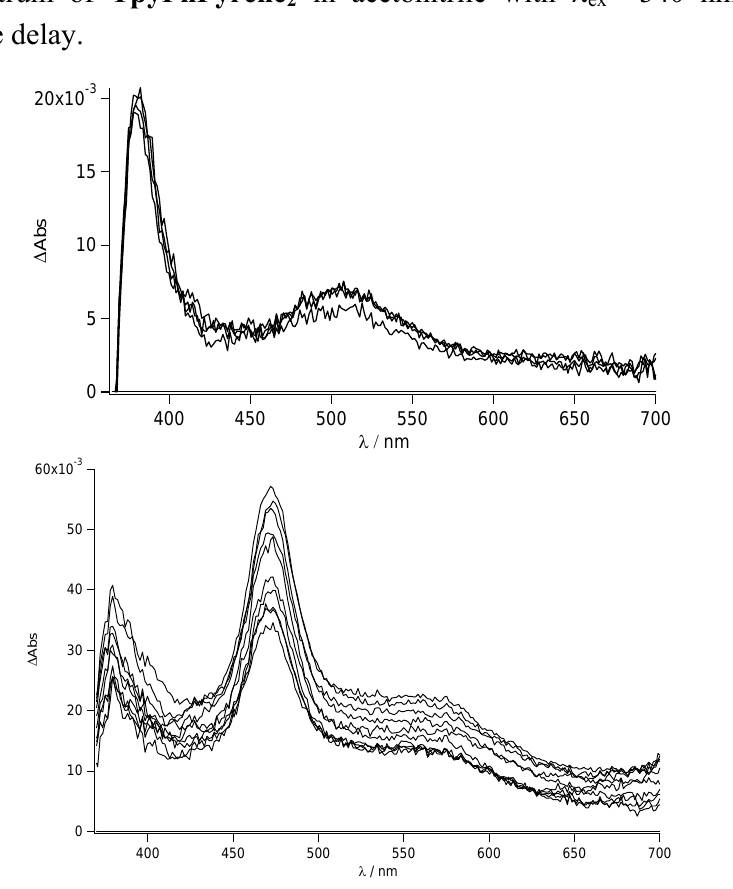
in THF 2 in acetonitrile with  = 340 nm and 100 ps 2 ex